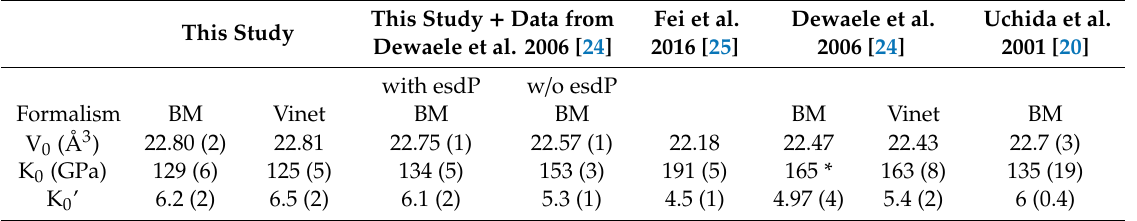
Table 1. Pressure volume equations of state fit results. Values in parenthesis are the published error bars. This Study + Data from Fei et al. Dewaele et al. Uchida et al. This Study Dewaele et al. 2006 [24] 2016 [25] 2006 [24] 2001 [20] with esdP w / o esdP Formalism BM Vinet BM BM BM Vinet BM V 0 (Å 3 ) 22.80 (2) 22.81 22.75 (1) 22.57 (1) 22.18 22.47 22.43 22.7 (3) K 0 (GPa) 129 (6) 125 (5) 134 (5) 153 (3) 191 (5) 165 * 163 (8) 135 (19) K 0 ’ 4.5 (1) 4.97 (4) 5.4 (2) 6